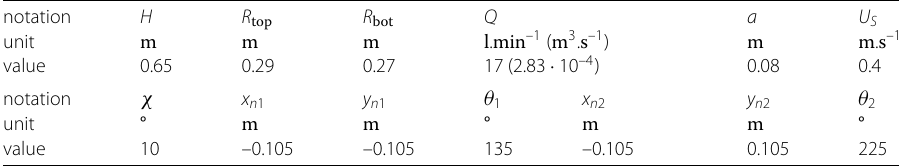
Table 1 Default parameters of the 3d ladle stirring model from [9]. The value for Q is used as maximal value in the numerical studies presented here